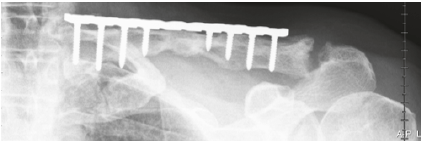
Figure 5: Twelve months after plate osteosynthesis. Good develop- ment of the slowed